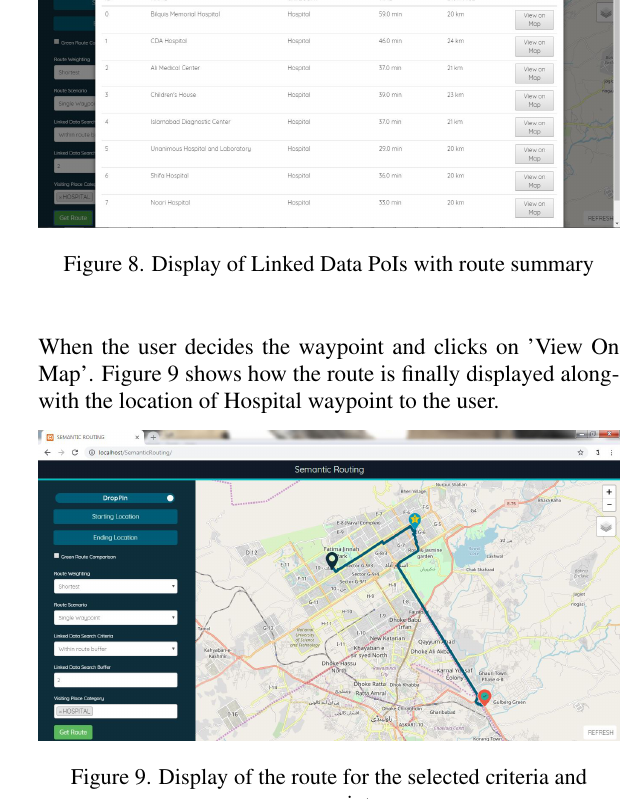
Figure 9. Display of the route for the selected criteria and